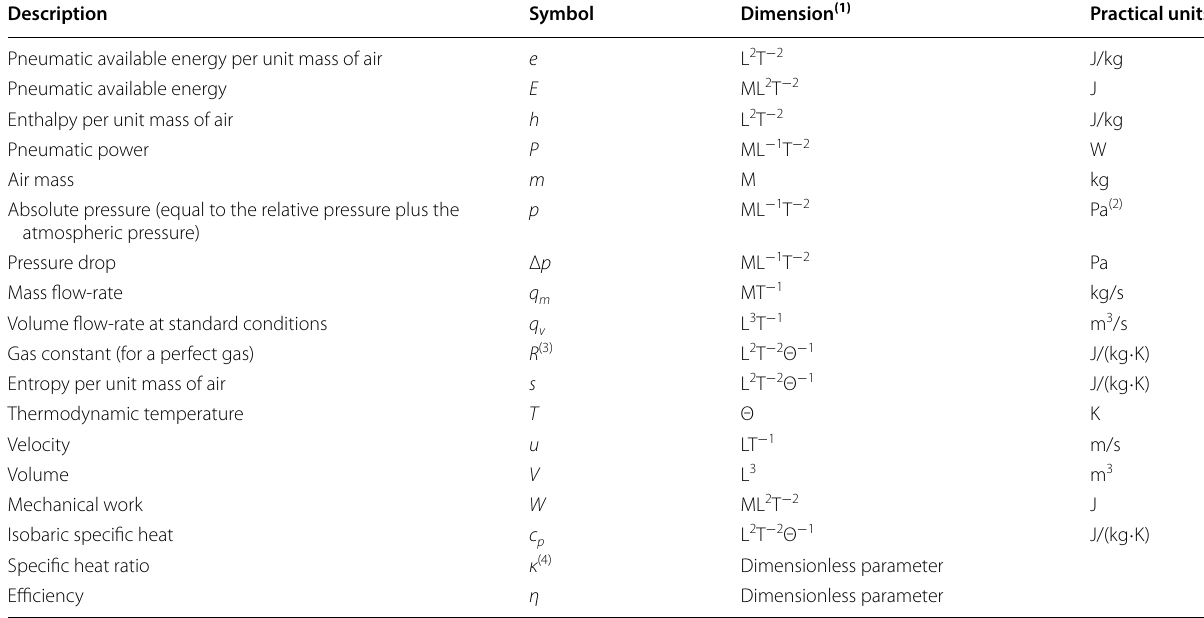
Table 1 Symbols and units